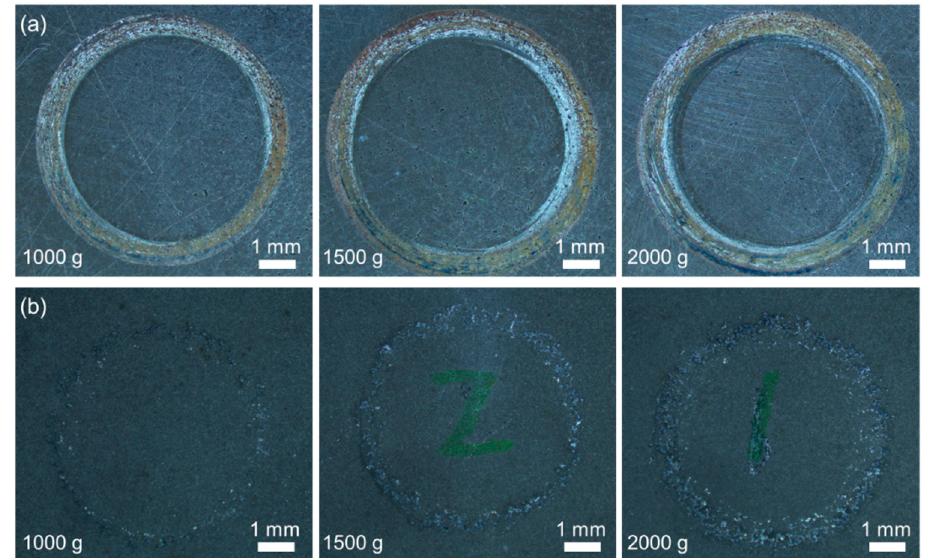
Figure 10. Surface morphologies of the ( a ) 27CrMoV substrate and ( b ) WC–10Co4Cr coatings after friction test at different loads.